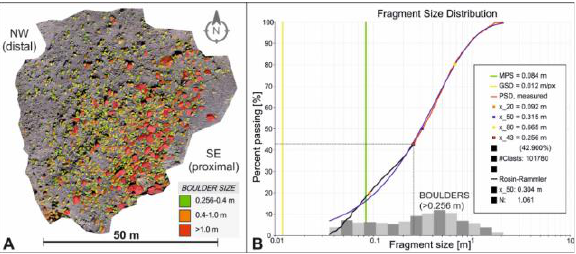
Figure 7. ( A ) Boulder-size fragment distribution map within the Mana coarse-clast deposits. ( B ) Frag- ment size distribution diagram for all detectable fragments and fitted R-R distribution (Fragmenter; 3GSM GmbH). The minimum size of a fragment depends on the 3D point spacing and the image resolution. MPS—median point spacing, GSD—ground sample distance.